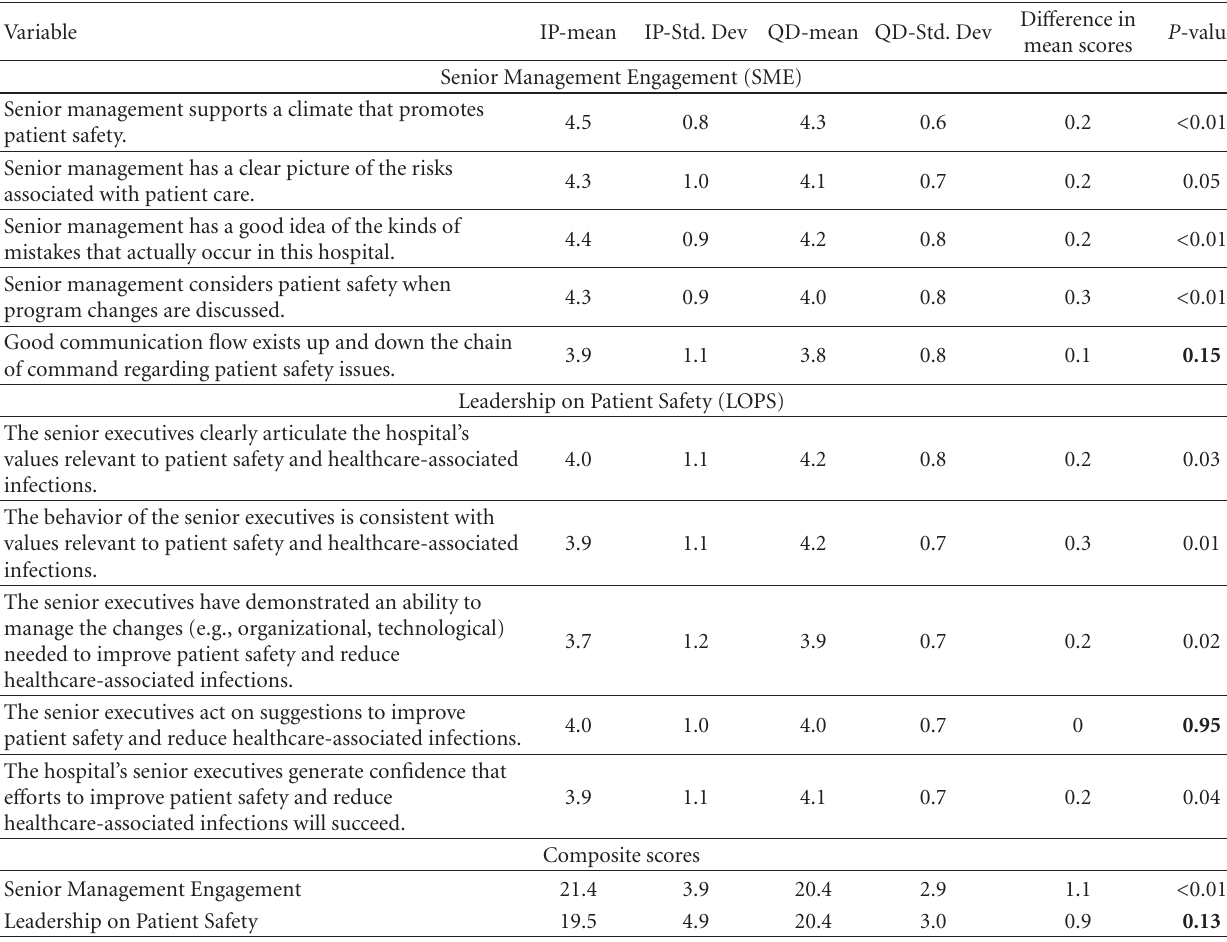
Table 2: Patient safety climates by personnel